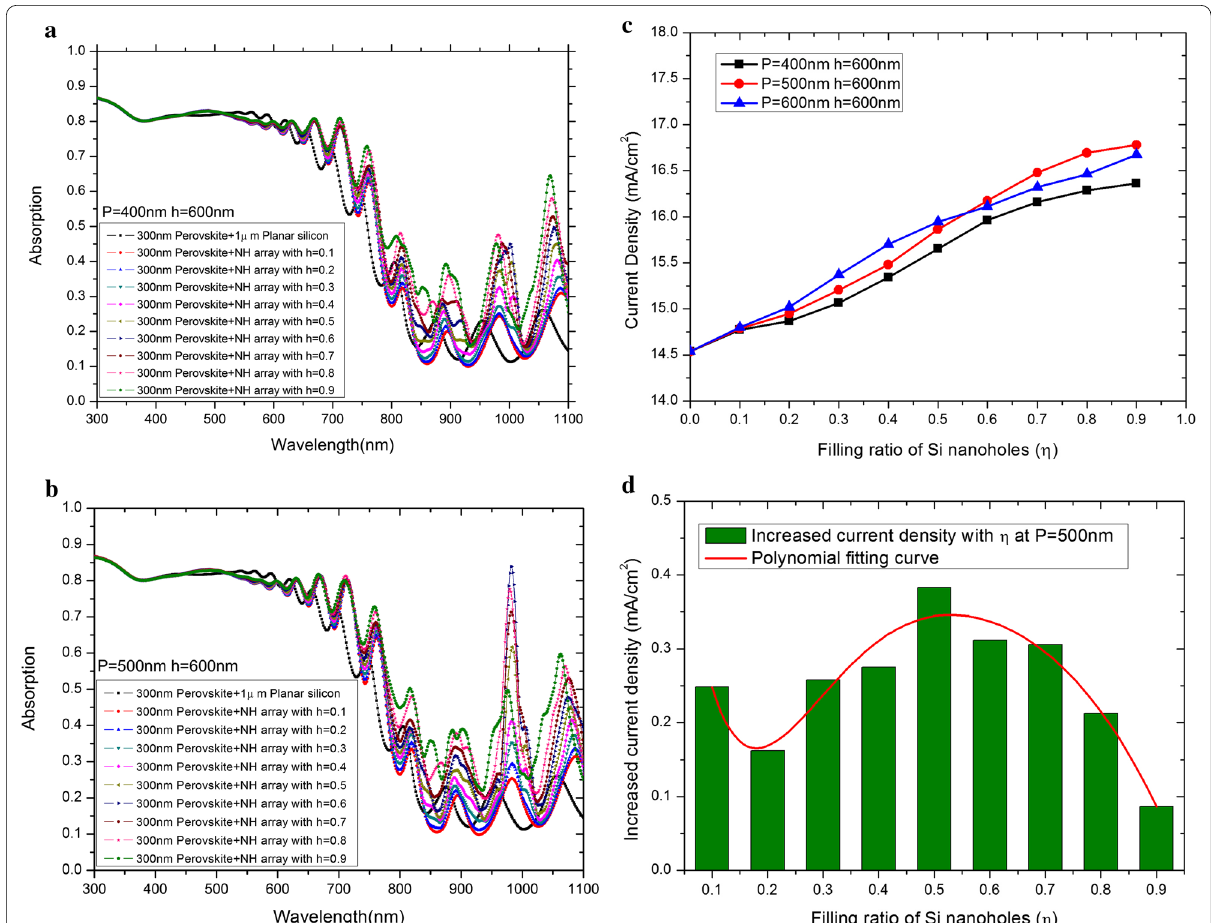
Fig. 3 Optical characterization of tandem solar cells with nanoholes array. a Absorption spectra versus filling ratios at fixed P h 600 nm. b Absorption spectra versus filling ratios at fixed P = periods. d Increasing photocurrent density versus the filling ratios under the condition of P